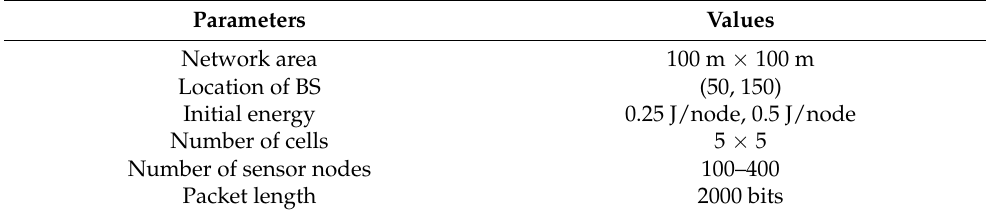
Table 1. Simulation